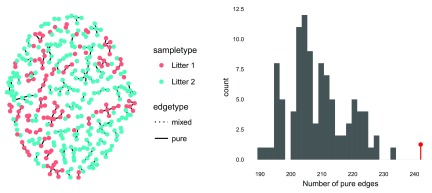
The graph and permutation histogram obtained from a nearest-neighbor graph with Jaccard similarity.